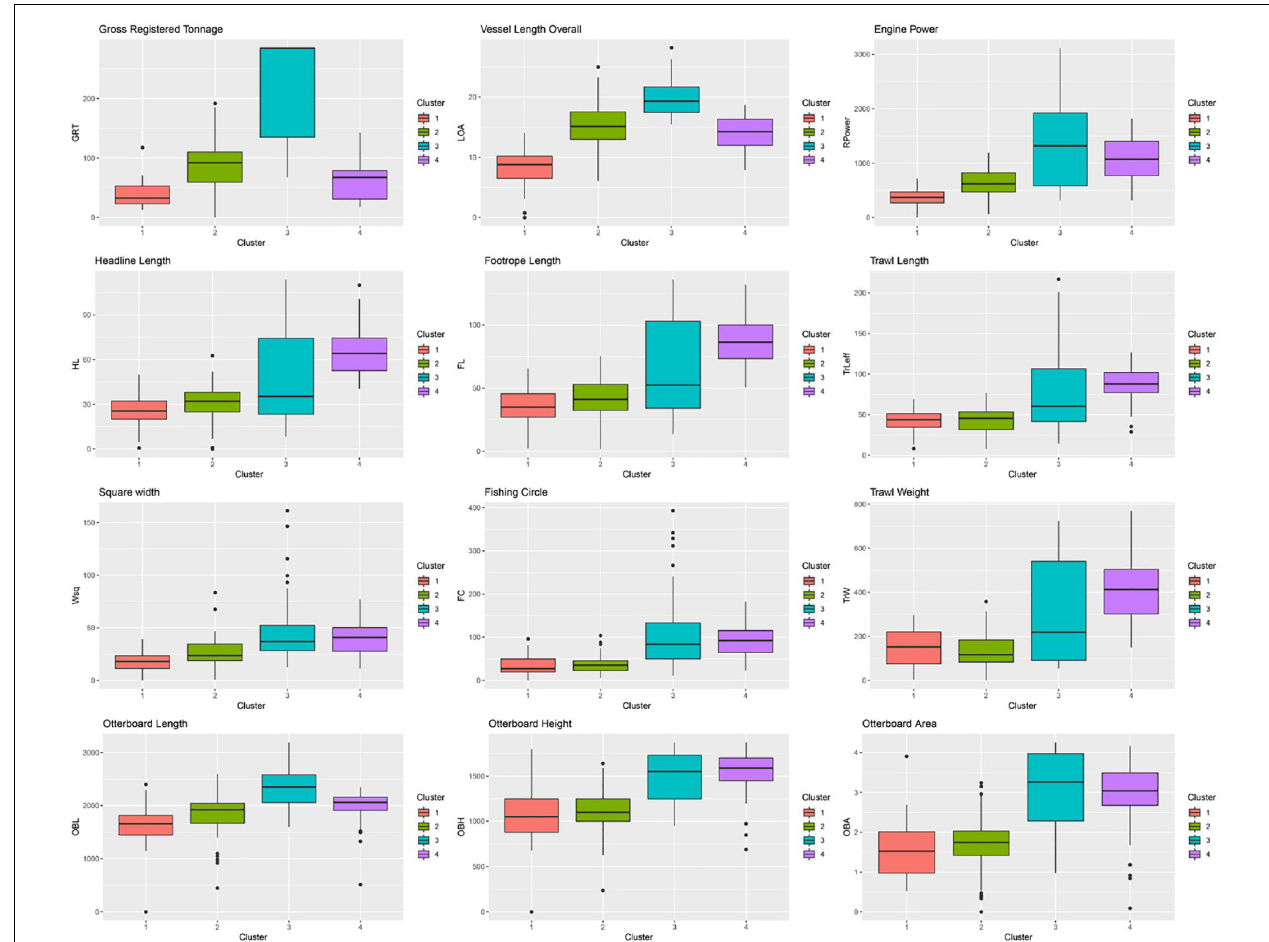
FIGURE 6 | Description of each variable range, median and interquartile ranges divided by